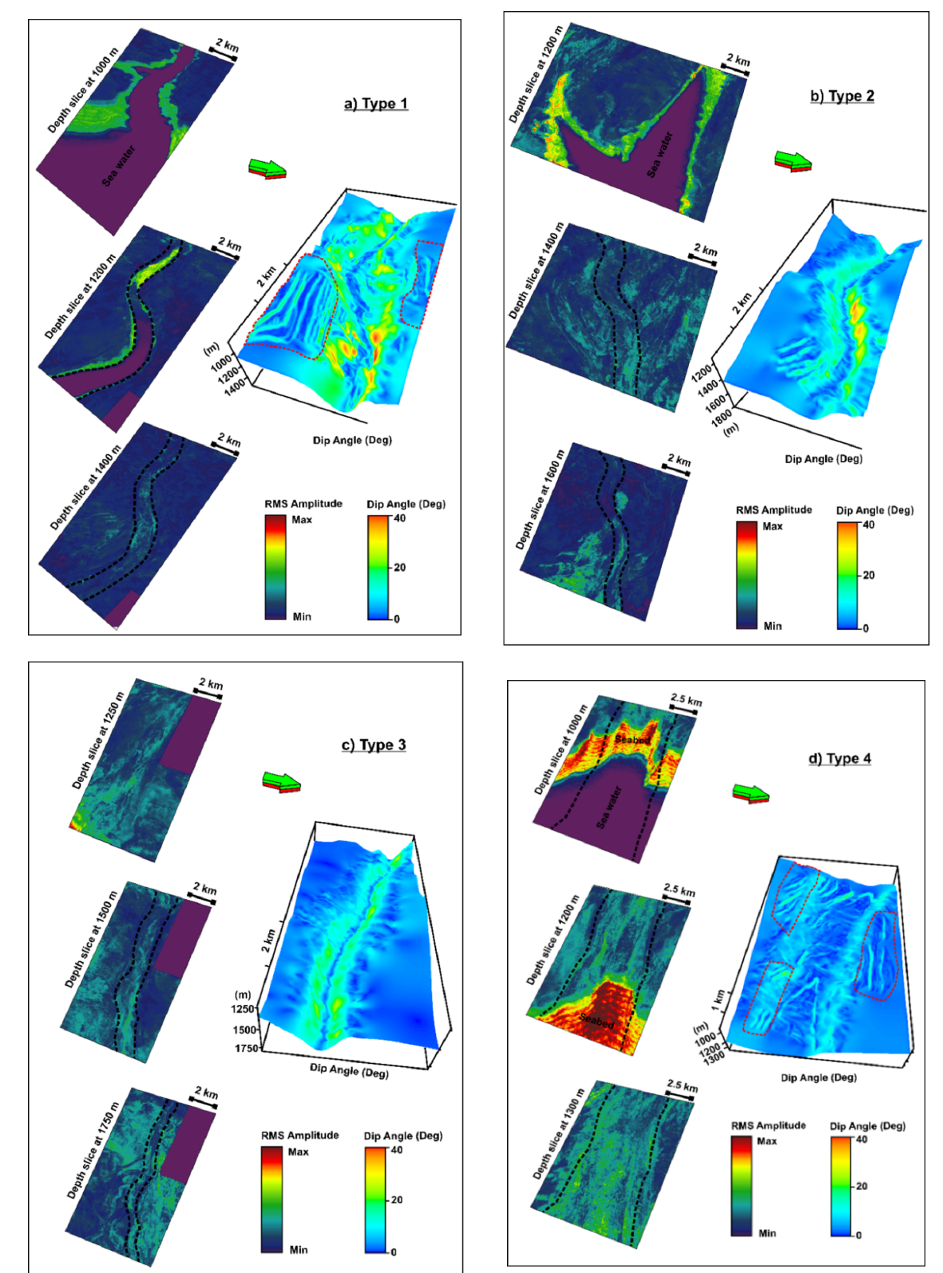
Figure 2. 3D view of dip angle ( right images) and depth root-mean-square (RMS) amplitude slice from 3D seismic reflection data ( left images) of ( a ) Type 1, ( b ) Type 2, ( c ) Type 3, and ( d ) Type 4 channel complexes in the Canterbury Basin, offshore of New Zealand [46]. Note that the black dashed line is the channel outline, while the red dashed line is the area of the contourite deposit.